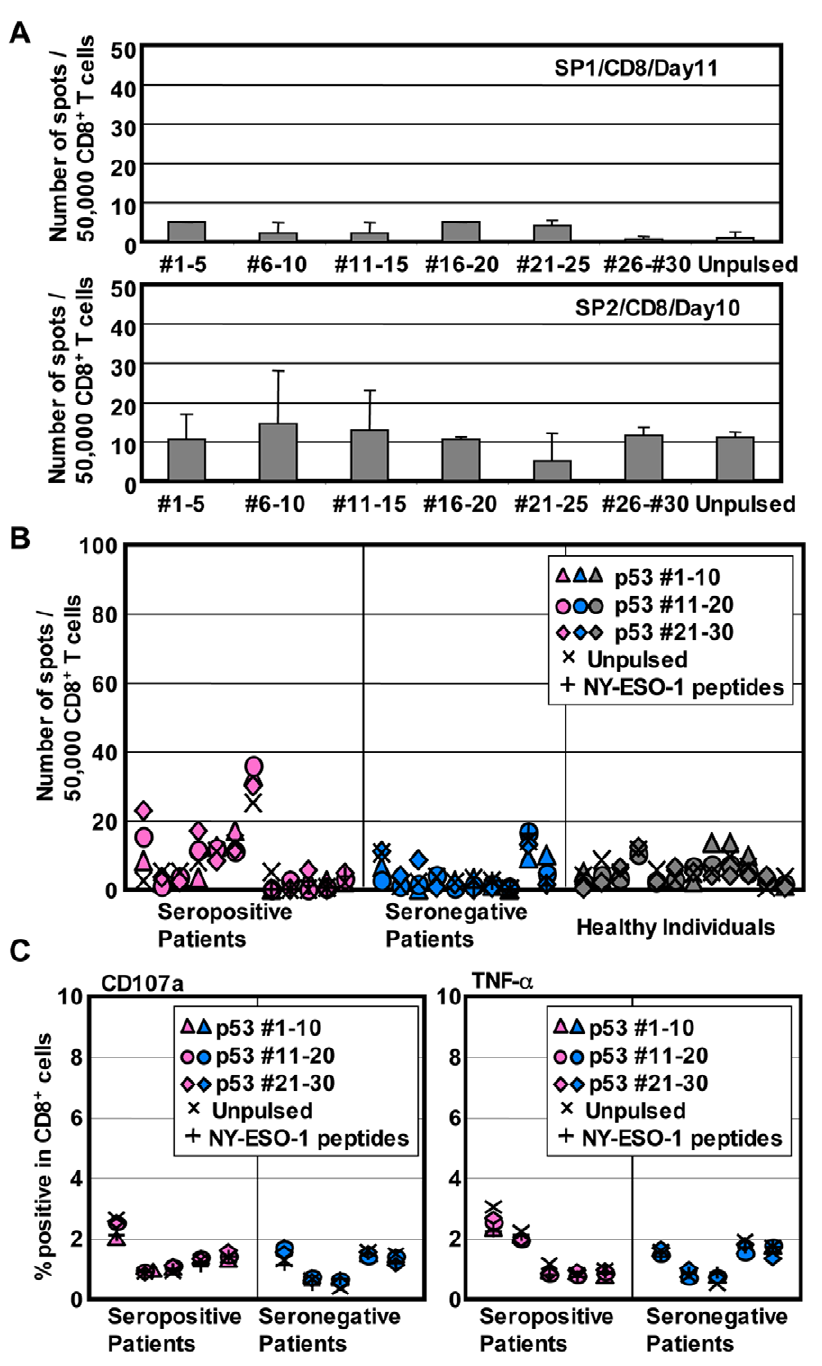
Figure 2. Undetectable p53-specific CD8 + T cells in ovarian cancer patients and healthy donors. (A) CD8 + T cells from antibody positive ovarian cancer patients were presensitized with a pool of 30 p53 overlapping peptides. After 9–12 days, p53-specific IFN- c producing T cells were evaluated by ELISPOT assays. Error bars represent standard deviation (SD) of duplicate wells. Autologous T-APCs were used as target cells in ELISPOT assays. (B) CD8 + T cell responses in 7 seropositive and 5 seronegative ovarian cancer patients and 12 healthy donors are shown. (C) Presensitized CD8 + T cells were analyzed by intracellular TNF- a staining and CD107a expression assays after restimulation with p53-peptides-pulsed, irrelevant (NY- ESO-1) peptides-pulsed or unpulsed target cells.